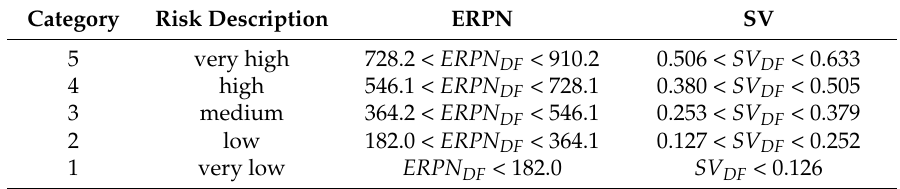
Table 3. Categorization of the economic risk priority number (ERPN) and weighted technical severity values